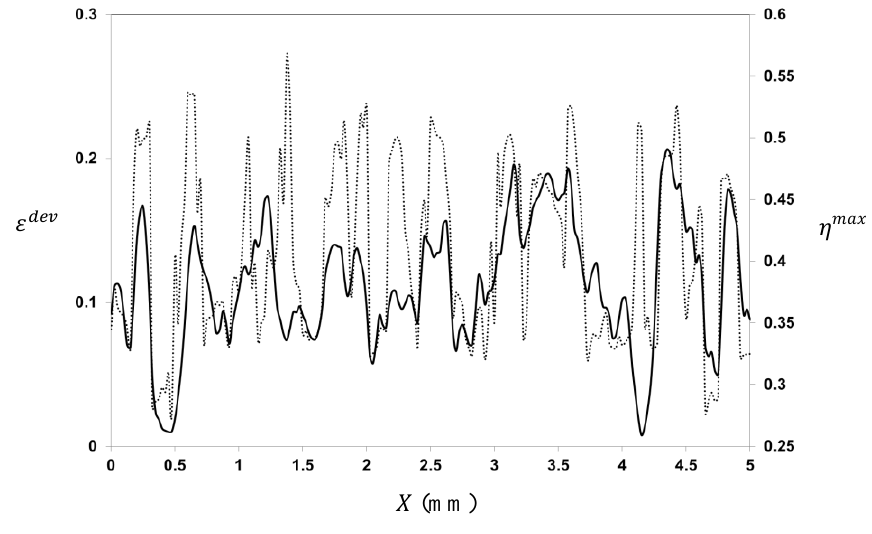
Fig. 3. Strain (solid line) and Schmid factor (dotted line) profiles on the 𝑋 -axis for the 4000 grain aggregate for stretching rate 𝐹̇ 𝑋𝑋 = 5000 s -1 at time 𝑡 = 20